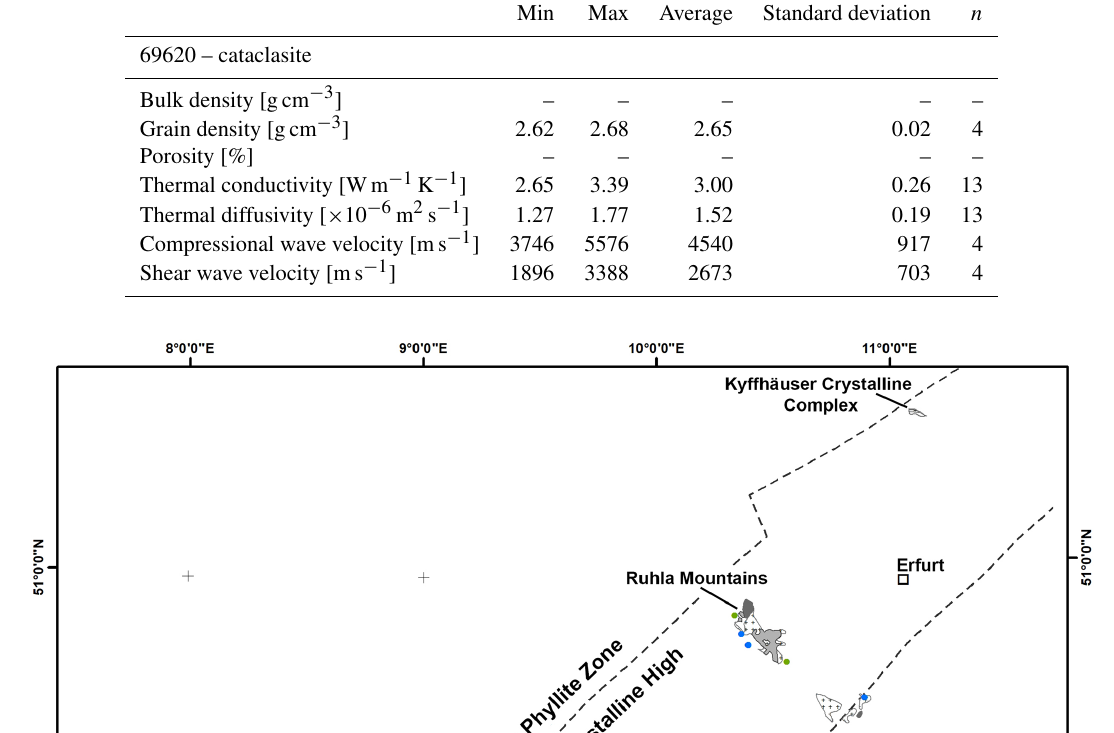
Earth Syst. Sci. Data, 13, 1441–1459, 2021